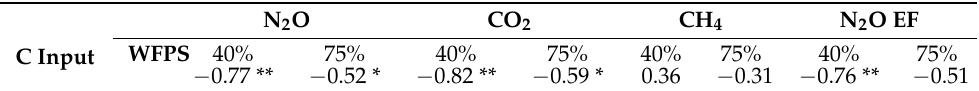
Table 5. Pearson correlation coefficients between carbon (C) inputs and emissions of nitrous oxide (N 2 O), carbon dioxide (CO 2 ), and methane (CH 4 ) and N 2 O emission factor (EF) in 40% and 75% water-filled pore space (WFPS).